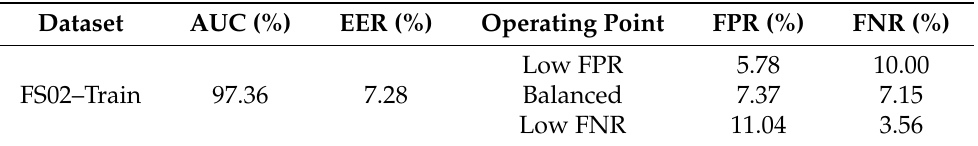
Table 3. AUC, EER, FPR and FNR on three operating points for the pseudo-labels obtained using the baseline model on FS02 training partition.